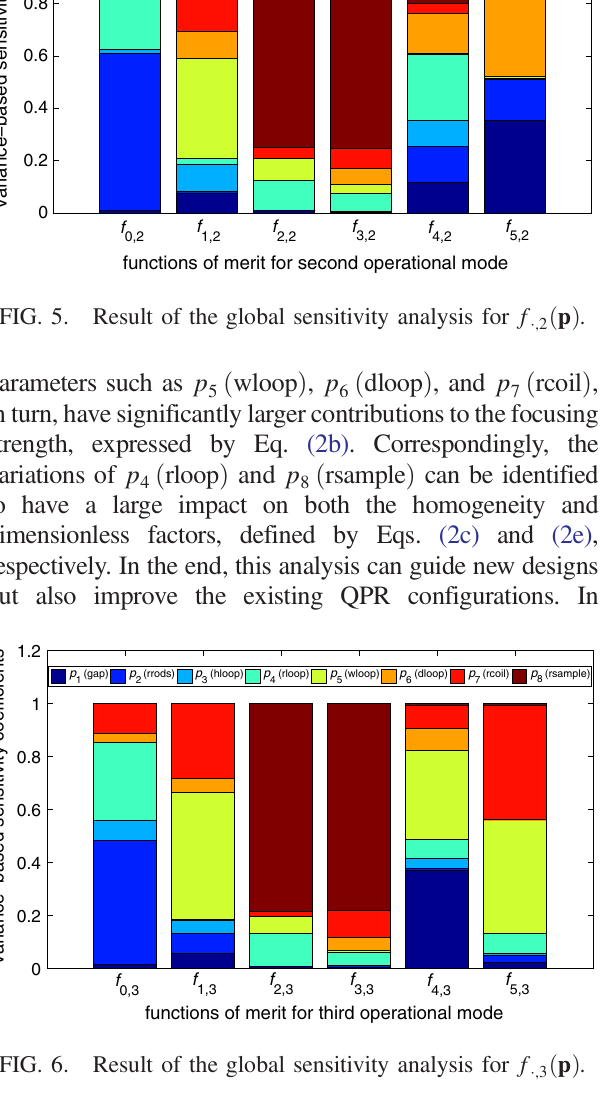
FIG. 6. Result of the global sensitivity analysis for f